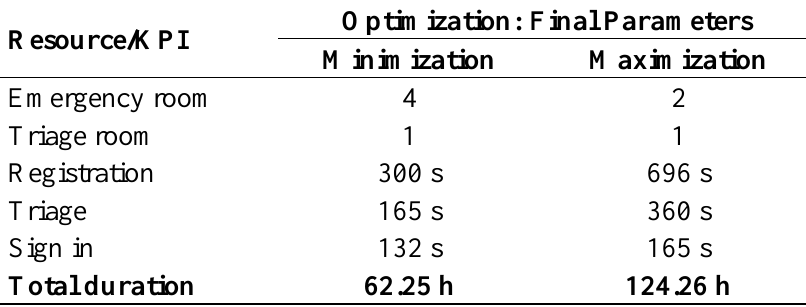
Table 11. Interval-valued results.